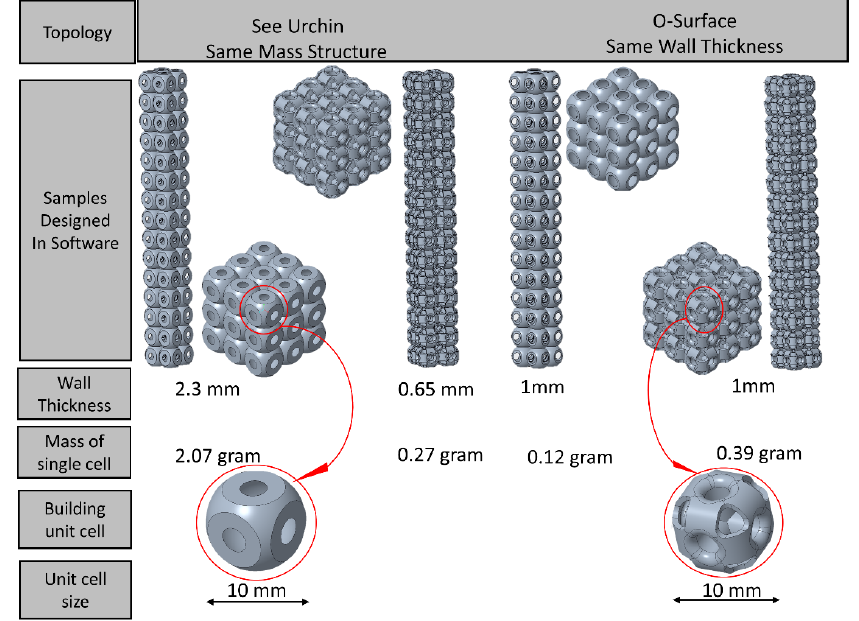
Figure 2. Pictorial representation of structures based on mass and wall thickness. Table 1. The complete dimension of all the samples.